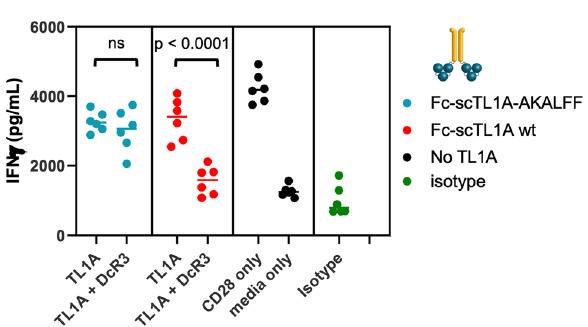
Figure 6. Fc-TL1A-AKALFF was Immune to DcR3-Based Inhibition. T cells were treated with 0.1 mg of immobilized anti-CD3 antibody alone or in the presence of exogenous DcR3 at 10 mg/mL. Either Fc-scTL1A (red) or Fc-scTL1A AKALFF (blue) was used to co-stimulate T cells. Anti-CD28 Ab was used as a co-stimulatory positive control. Anti-CD3-activated T cells without co-stimulatory signal was used as negative control. IFNg levels were measured by MSD assay. Stastical significance was determined using an unpaired T-test for each construct and data represents averages from three independent experiments using a single T cell donor. Graphs were generated using Graphpad Prism (Version 9): https:// www. graph pad. com/ scien tific- softw are/